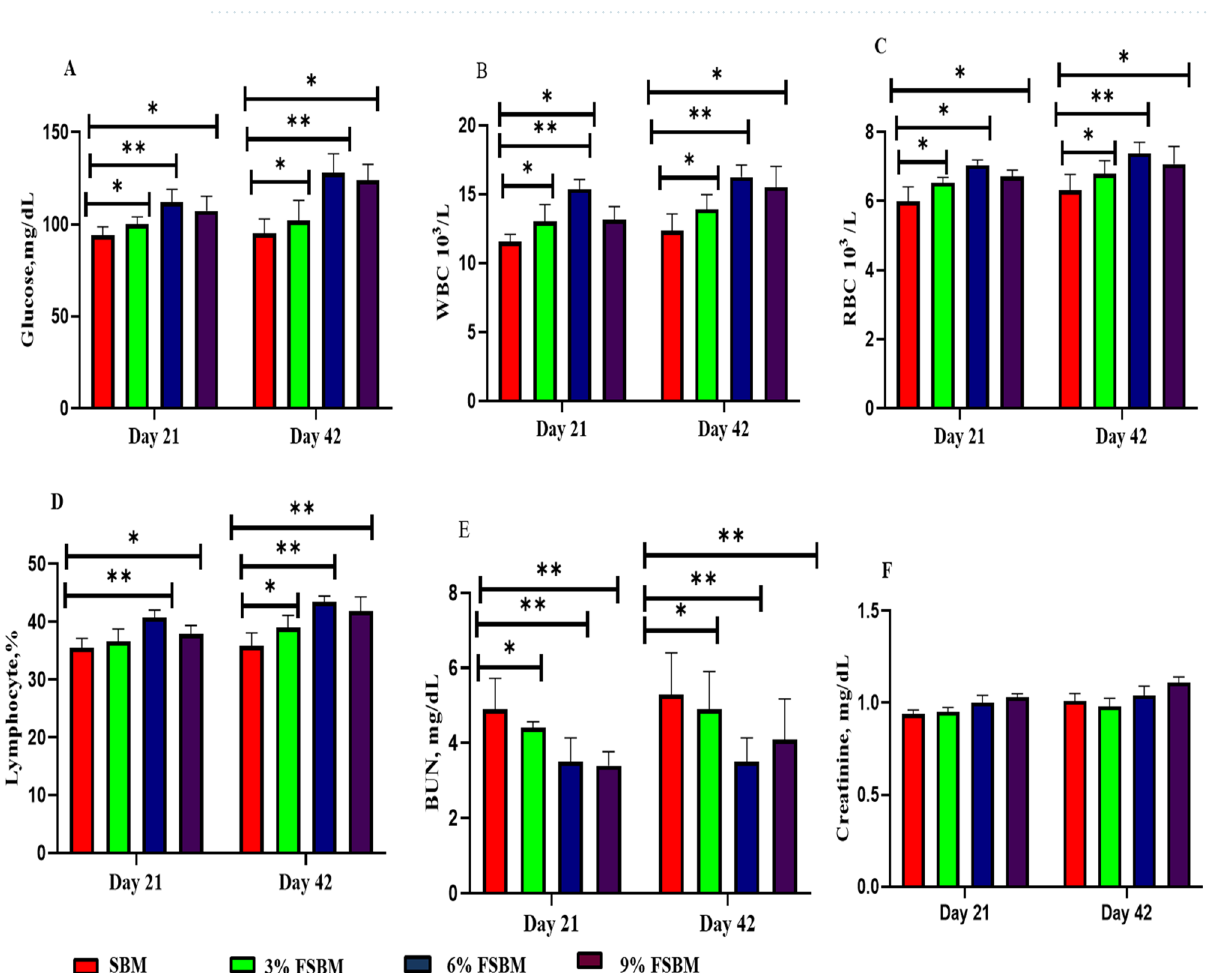
Figure 4. Effect of fermented soybean meal (FSBM) on blood profiles in piglets. ( A ) Glucose levels. ( B ) White blood cell (WBC). ( C ) Red blood cell (RBC). ( D ) Lymphocyte. ( E ) Blood urea nitrogen (BUN). ( F )